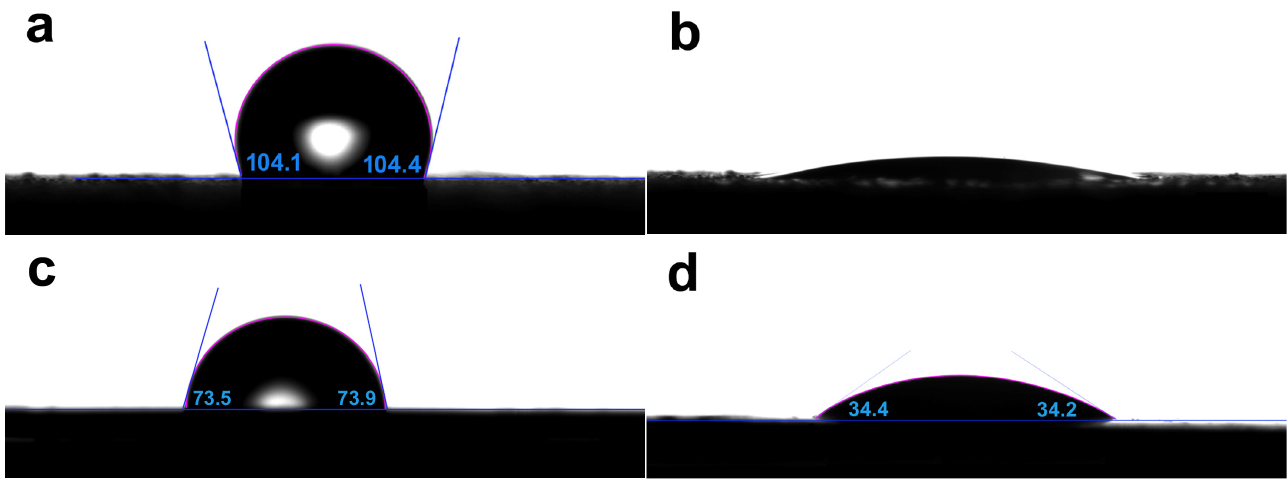
Figure 4. Water contact angles of ( a ) SLM-Ti, ( b ) MBG-SLM-Ti, ( c ) CP-Ti and ( d ) MBG-CP-Ti, showing the difference in wettability.